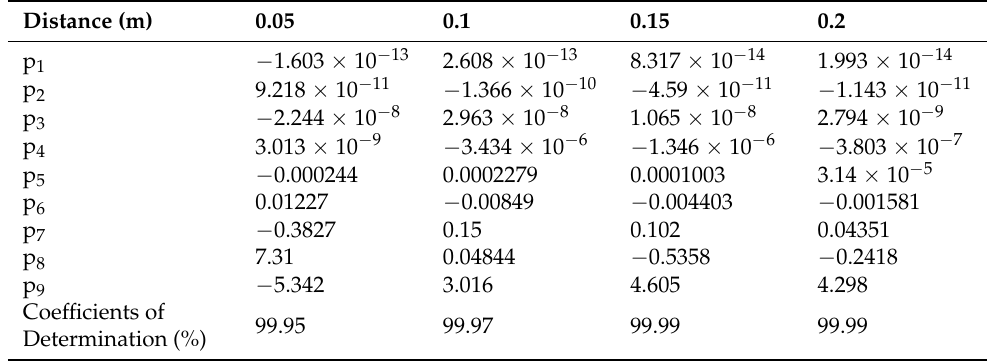
Table 2. Fitting